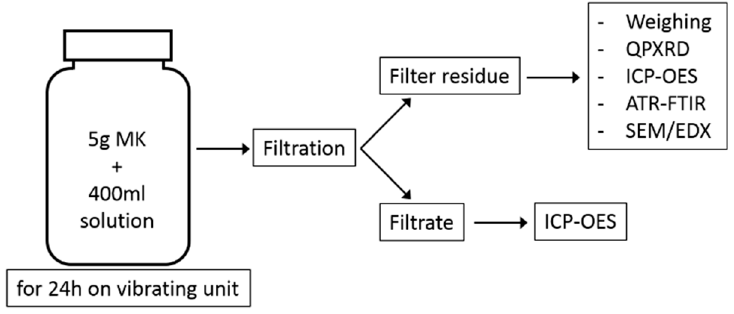
Figure 2. Schematic illustration of the test program.